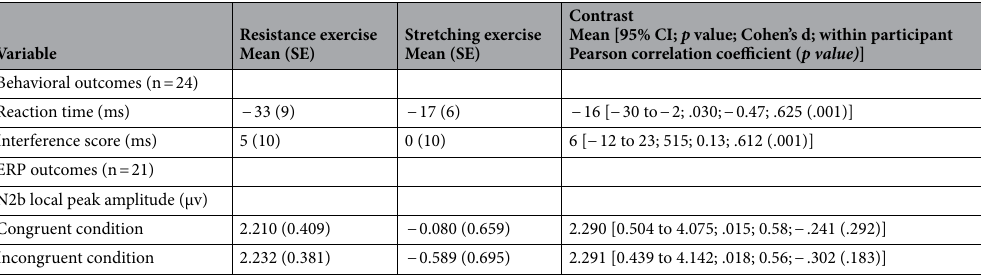
Table 2. Results for effects of each intervention and within-participants